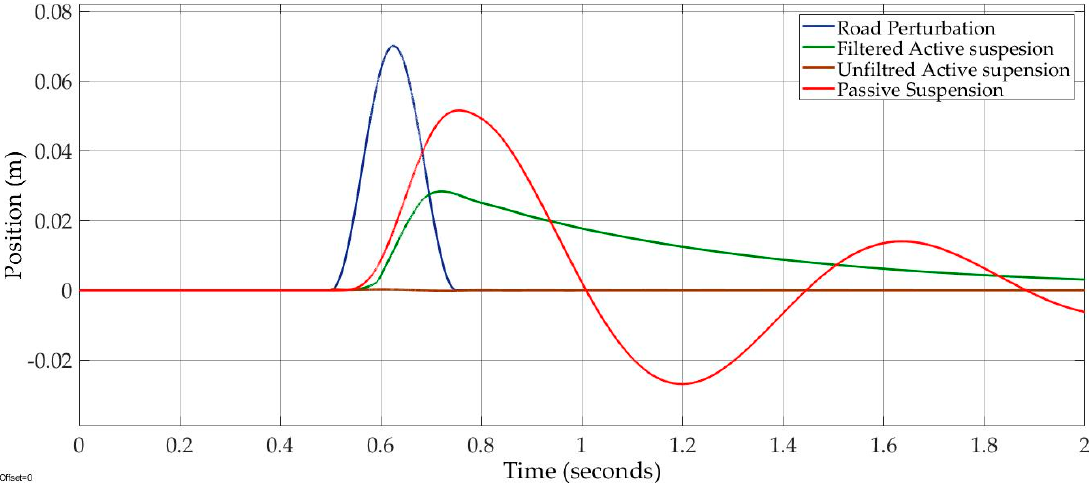
Figure 14. Sprung mass position of Case 3.